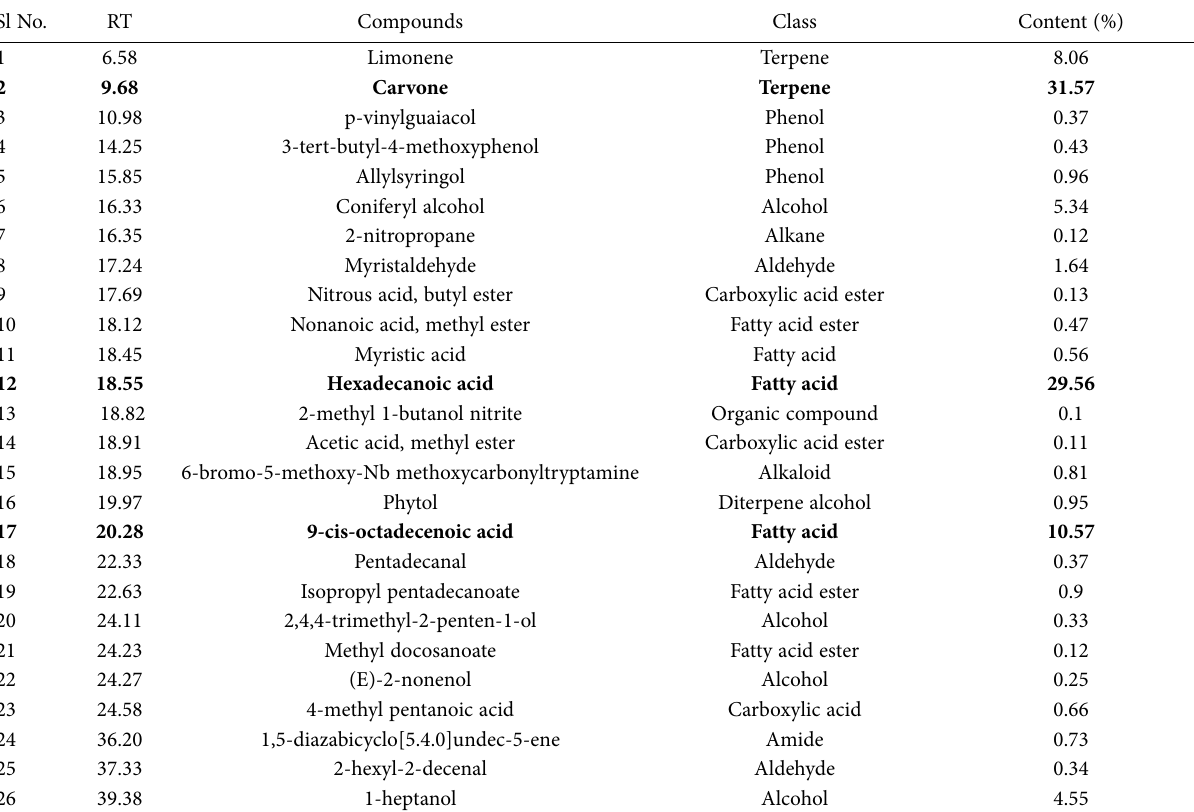
Table 1. Chemical composition of C. viminale as analysed by GC/MS. Sl